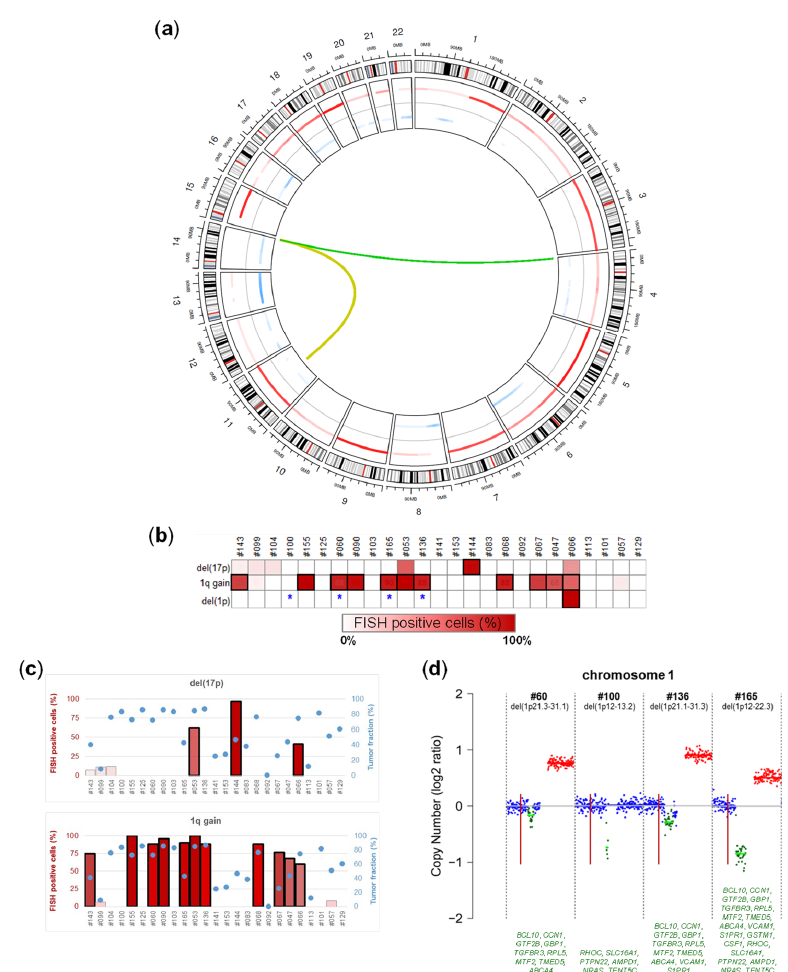
Figure 3. Chromosomal alterations characterizing the genome of asymptomatic multiple myeloma. ( a ) Circos plot showing genome-wide copy number abnormalities (from ULP-WGS) and chromosomal translocations involving the IGH locus (from FISH analysis) found in tumor samples from six MGUS and 25 SMM patients. Autosomes are arranged around the circle, starting from the top at chromosome 1 and continuing clockwise to chromosome 22. Copy number data are presented on the inside of the circle, showing gains/amplifications (first track, red), normal copy number (second track, grey), and deletions (third tack, light blue). Immunoglobulin heavy chain locus (IGH@) translocations are shown as green lines emerging from chromosome 14 to their respective partner chromosomes. The color intensity of gained and lost segments and the thickness of the lines indicating IGH translocations heighten with an increasing frequency of that anomaly in the cohort. ( b ) Heatmap representing the percentage of cells carrying each of the indicated chromosomal copy number alterations, as detected by FISH analysis. Each column represents one tumor sample and each row represents one CNA. Samples that tested positive for the corresponding lesion by ULP-WGS analysis are framed. N.a., not available. ( c ) Bar graphs representing the percentage of cells carrying each of the indicated chromosomal copy number alterations, as detected by FISH analysis (left vertical axis), in the 25 SMM patients. IchorCNA-estimated tumor fraction in the plasma cell (PC) gDNA of each patient is indicated by a light-blue circle (right vertical axis). Samples that tested positive for the corresponding lesion by ULP-WGS analysis are framed. ( d ) Chromosome 1 copy ratios computed by ichorCNA from ULP-WGS data in four patients (marked by an asterisk in b) tested negative for del(1p) by FISH analysis. Amplification (red), loss (green), and copy neutral (blue) are indicated. The horizontal lines in light green indicate subclonal calls. The vertical red bar marks the location of the FISH probe. The main genes mapped in the deleted region in each patient are listed in the lower part of the